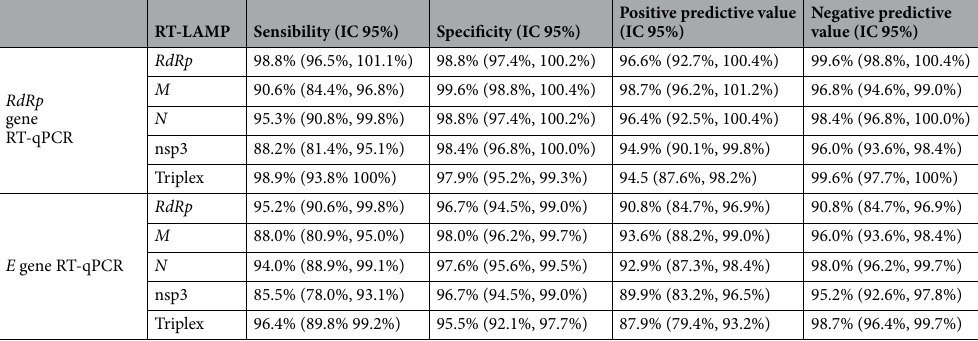
Table 3. Level of agreement of RT-qPCR results compared to all RT-LAMP